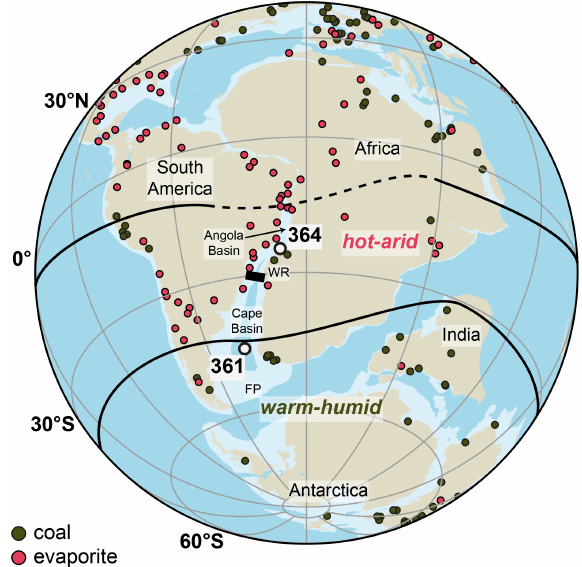
Figure 1. Aptian paleogeographic reconstruction (Matthews et al., 2016) showing the Early Cretaceous distribution of climate- sensitive rock types (Boucot et al., 2013; Cao et al., 2019). Position of climate belts according to Boucot et al. (2013) and Chumakov et al. (1995). Land–sea mask and distribution of shelf seas were adapted from Cao et al. (2017). WR stands for Walvis Ridge, and FP stands for Falkland